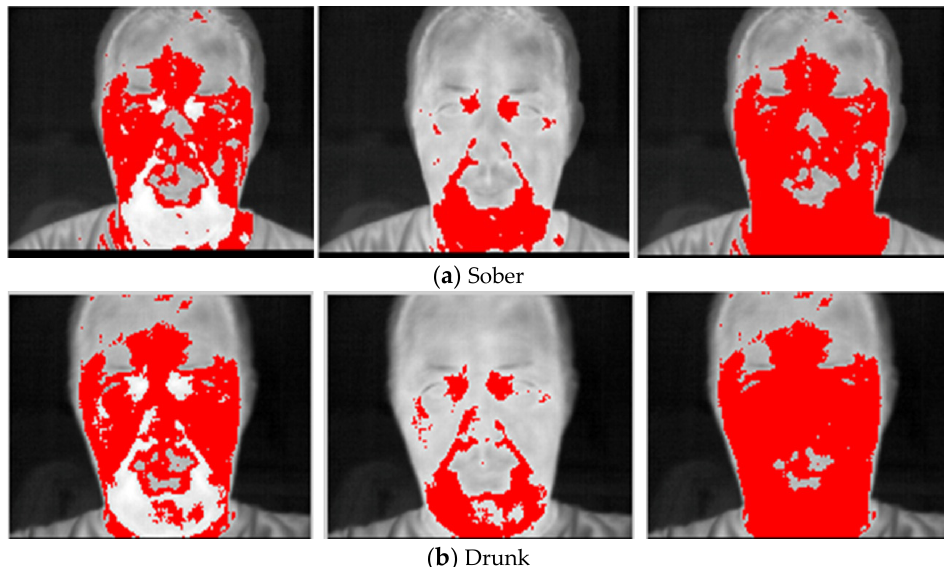
Figure 3. Isothermal regions obtained by dividing the histogram into ( a ) two regions, ( b ) four re- gions, ( c ) eight regions and ( d ) twenty regions.